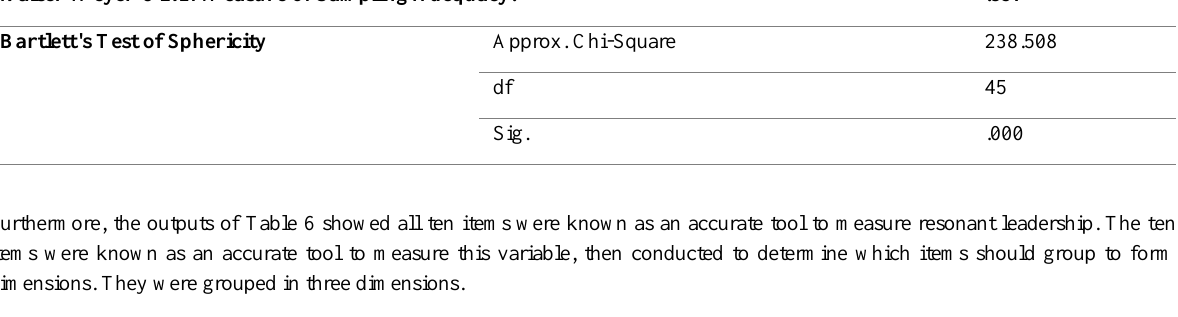
Table 5: Kaiser-Meyer-Olkin of the Resonant Leadership (n=45) Kaiser-Meyer-Olkin Measure of Sampling Adequacy.